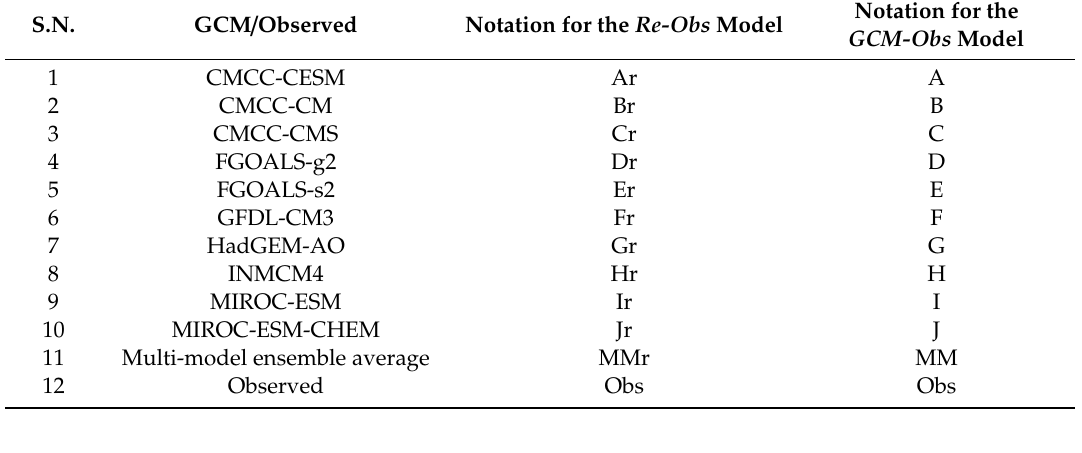
Table 8. Notations used in study for downscaling with di ff erent GCMs by Re-Obs and GCM-Obs models. S.N.